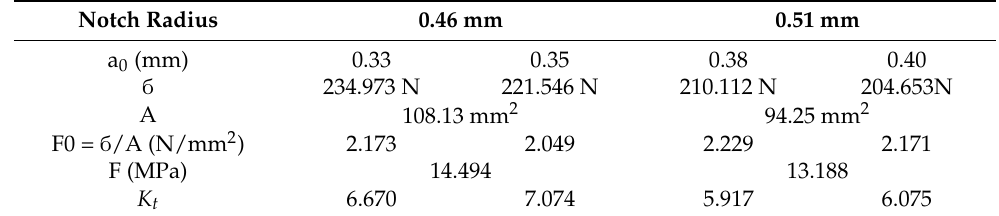
Notch Radius 0.46 mm